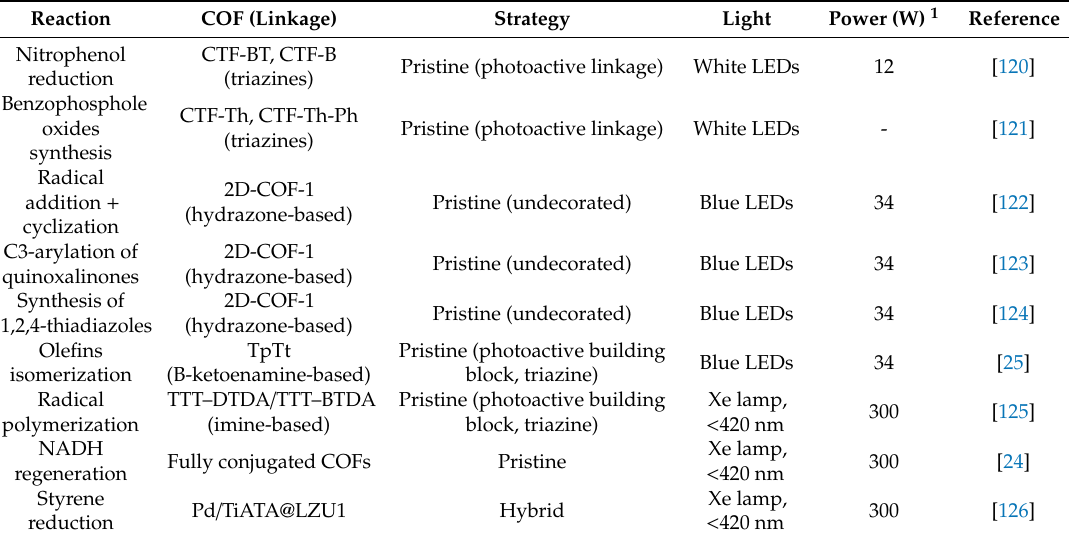
Table 17. Other photocatalytic organic transformations mediated by